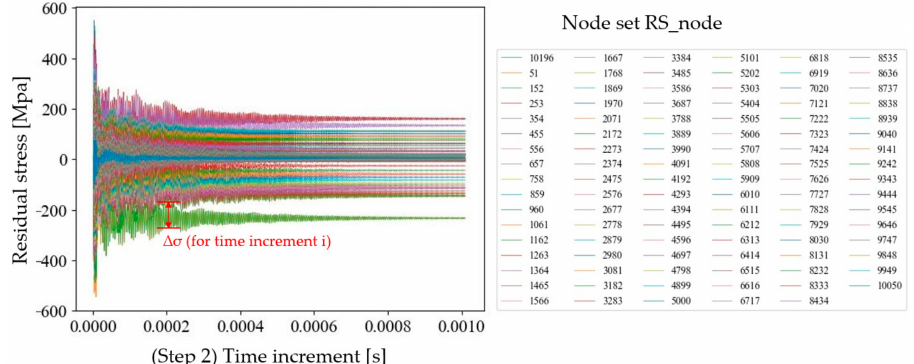
Figure 4. Exemplary residual stress amplitudes over step time with included nodes in RS_node.